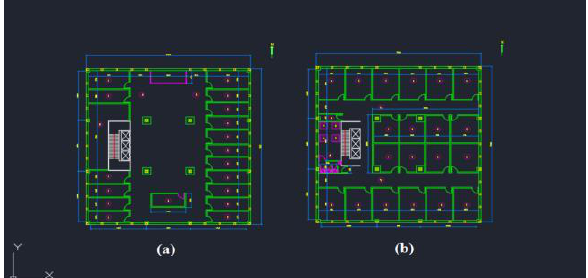
Figure 5. Drawing of Plasco building floors plan and its modification according to the available technical